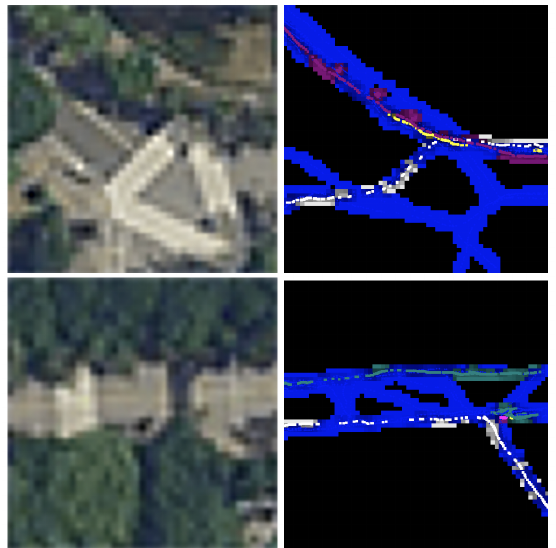
Figure 9. Classification Examples of maps and IMs for Photography (purple) and Navigation (green).